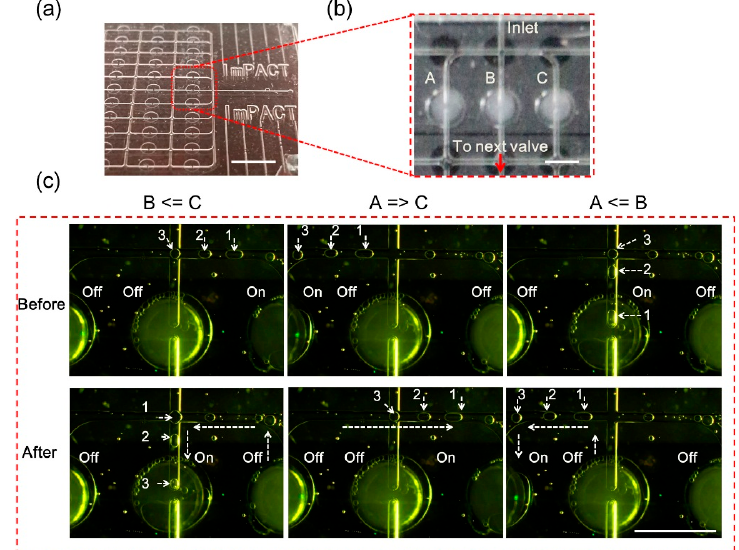
Figure 8. Demonstration experiment of channel selection using valves. ( a ) Photo of the microfluidic device prototype; ( b ) The location of the observed area and valve units used; ( c ) Results of the channel selection demonstration. B ≤ C before: initial state of valve A, off; B, off; C, on; positions of bubbles 1,